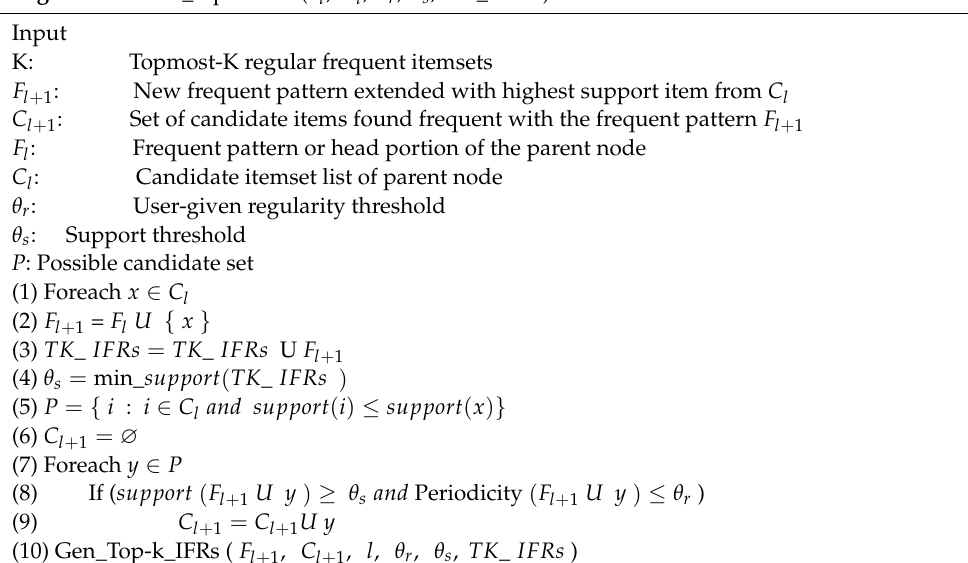
Algorithm 4 Gen_top-KIFRs ( F l , C l , θ r , θ s , TK _ IFRs